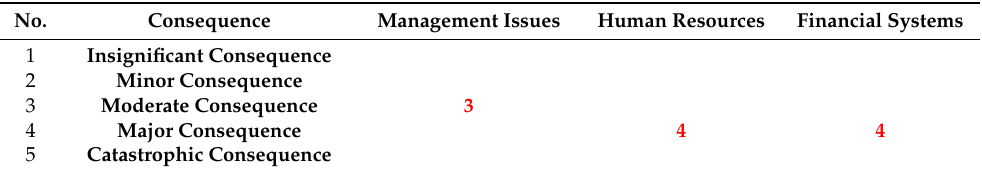
Table 4. Ranking of the Problem Areas in Priority